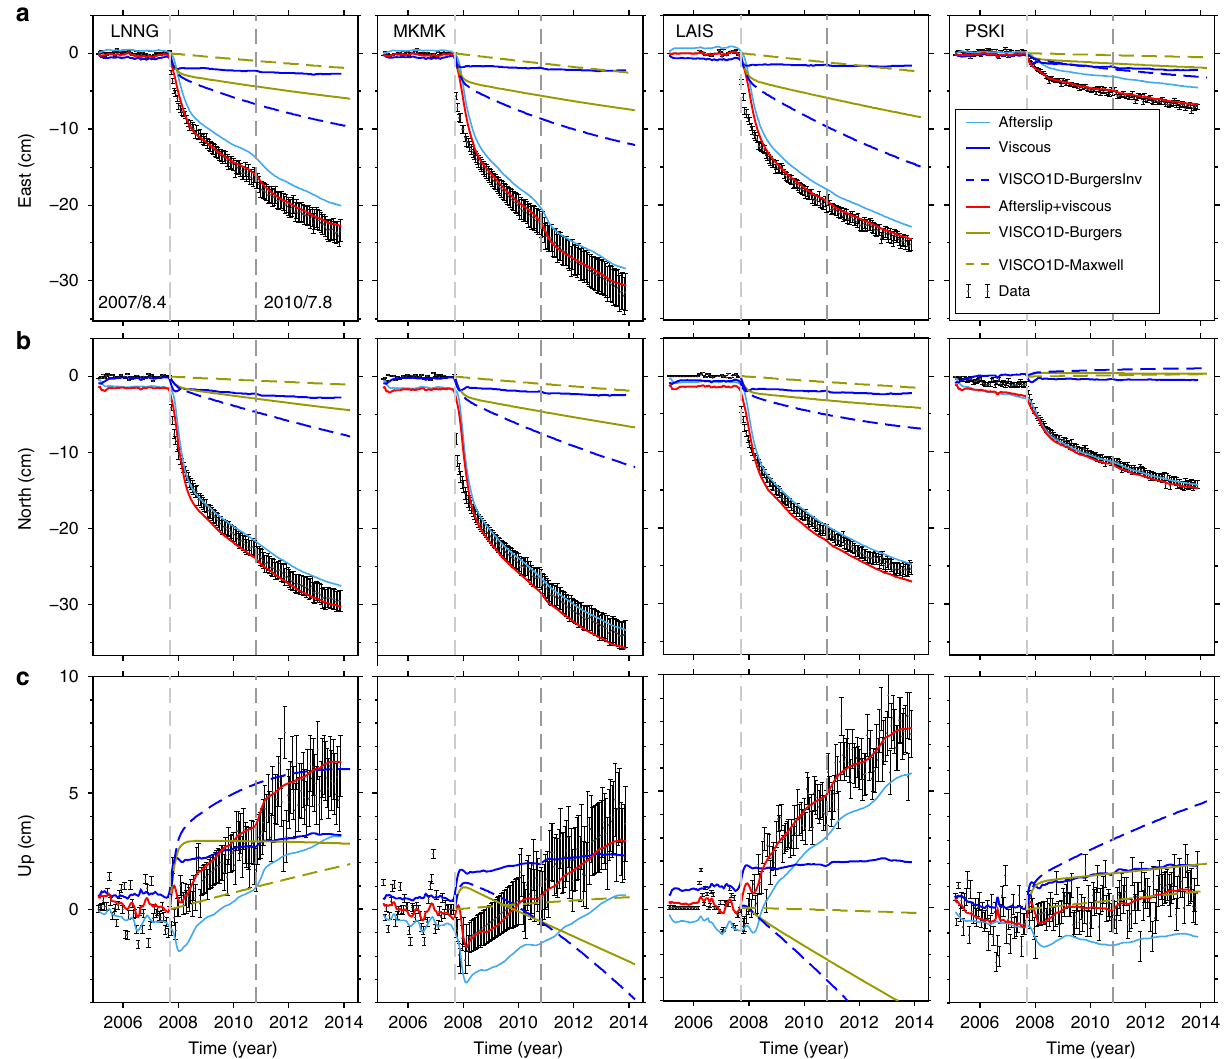
Fig. 5 A comparison of GPS time series and model predictions. Predictions are from both afterslip and viscoelastic fl ow from our inversion and dynamic VISCO1D forward model at sample stations (see Figs. 2 and 4). a , b , c The east-component, north-component and up-component displacements, respectively. Grey dots show the GPS data with 1 σ error bars. Afterslip and viscoelastic fl ow predictions from our inversion are shown in light blue (solid curves) and blue (solid curves), respectively, with their combined contribution shown in red. The forward model prediction by VISCO1D driven by the coseismic model from ref. 24 with the both Burgers, and Maxwell rheology model found at the 2004 rupture from ref. 16 , and transient and steady-state viscosity found at cuboid 2 (BurgersInv) are respectively shown as brown curves, brown dashed lines and blue dashed lines for